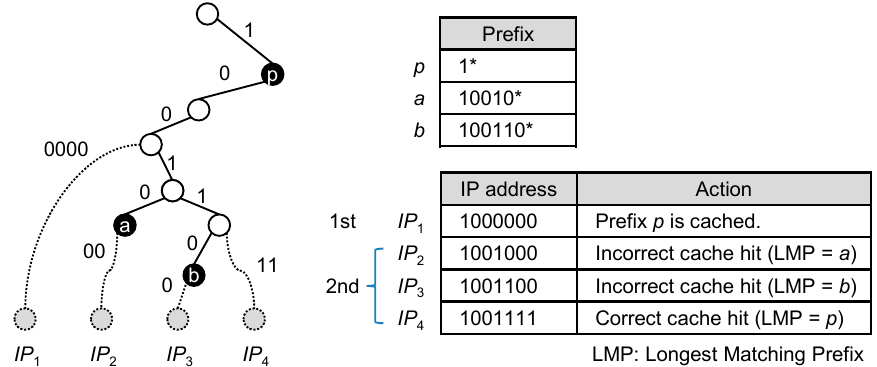
Figure 1. Example of the problem when caching non-leaf prefix p , supposing two consecutive packets arrive. While the destination of the first packet is IP 1 , that of the second packet is assumed to be one of IP 2 , IP 3 , and IP 4 .